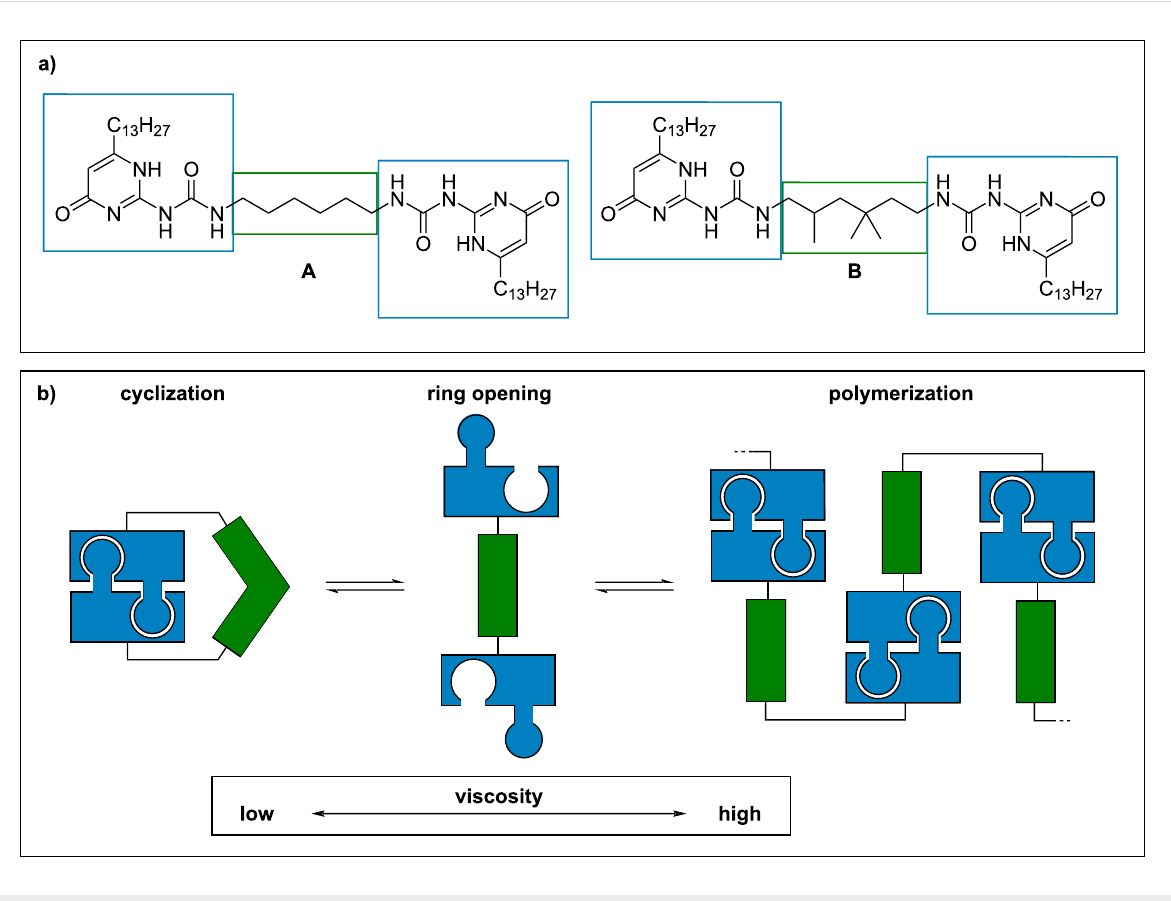
Figure 1: a) VII systems described by Sijbesma and Meijer, featuring two ureidopyrimidone BUs which are linked either via a linear hexylene linker (A) or via a branched 2,4,4-trimethylhexylene linker (B). b) Schematic mechanism of a supramolecular ring–chain